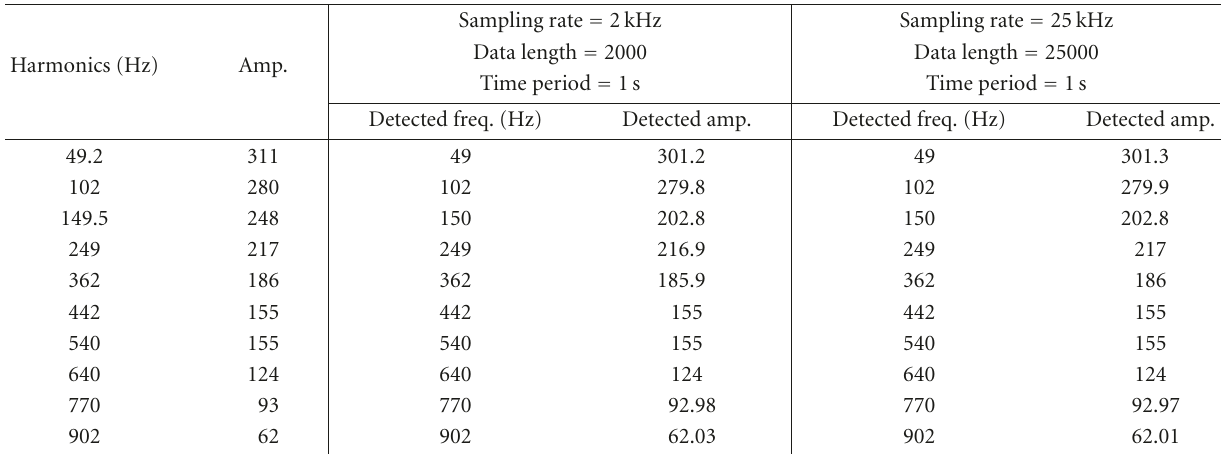
Table 5: FFT of the simulated signal.